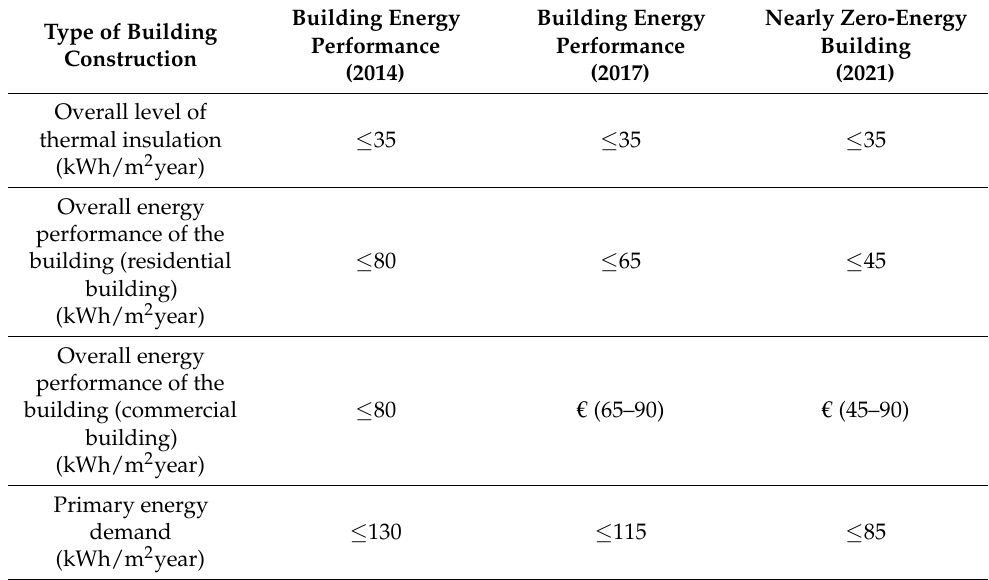
Table 1. Evolution of the energy performance requirements of buildings from 2014 to 2021 for the residential and commercial buildings in some European Union countries [19].